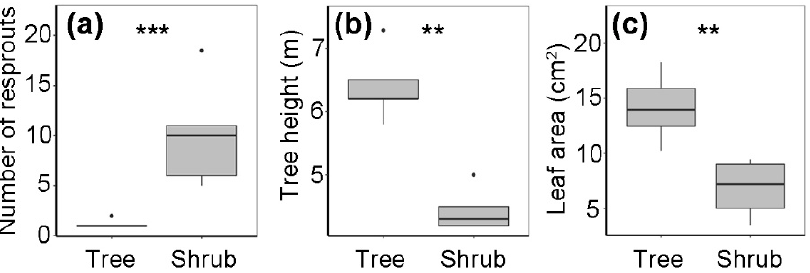
Figure 2. Box plots show the plant morphological differences between Quercus mongolica trees and shrubs for ( a ) number of resprouts, ( b ) tree height, and ( c ) leaf area. The horizontal lines represent the 25%, 50%, and 75% quantiles. The vertical lines show the 5% and 95% quantile. The stars show the results of a Wilcoxon rank-sum test: ***, p < 0.01; **, p < 0.05.